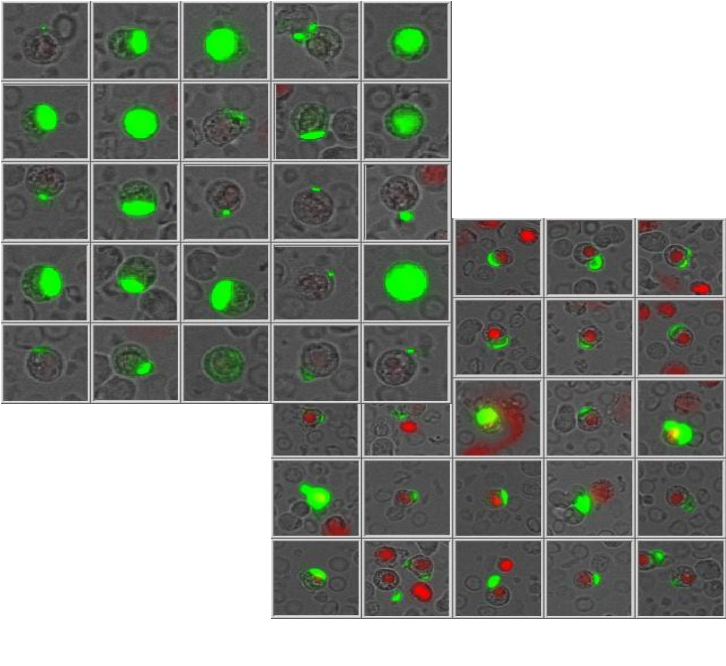
Figure 1. Gallery of vital (upper panel) and dead (lower panel) EpCAM-positive cells, typical cap formed surface staining covering a larger or smaller area on the cell.